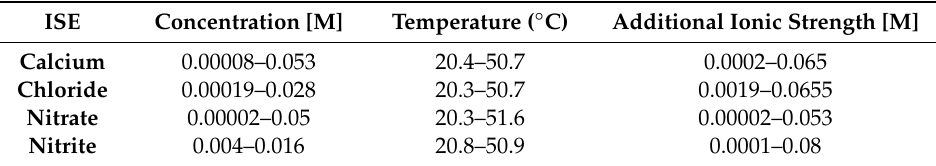
Table 1. Experimental Range for Ion selective electrodes (ISE) Evaluation.